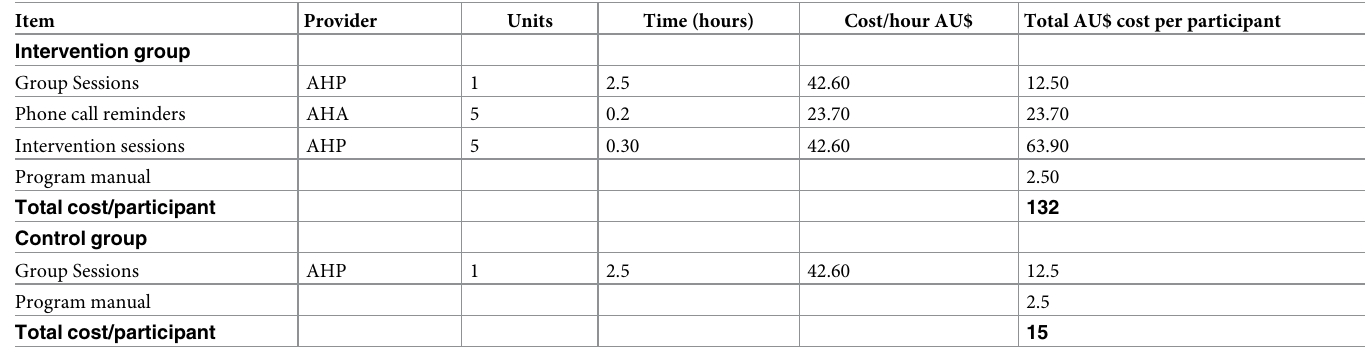
Table 1. Healthy 4U-2 programme delivery